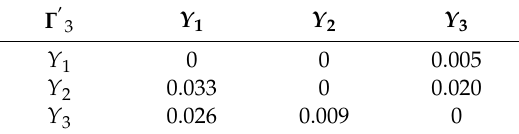
Table 23. The rejoice matrix Γ (cid:48) 3